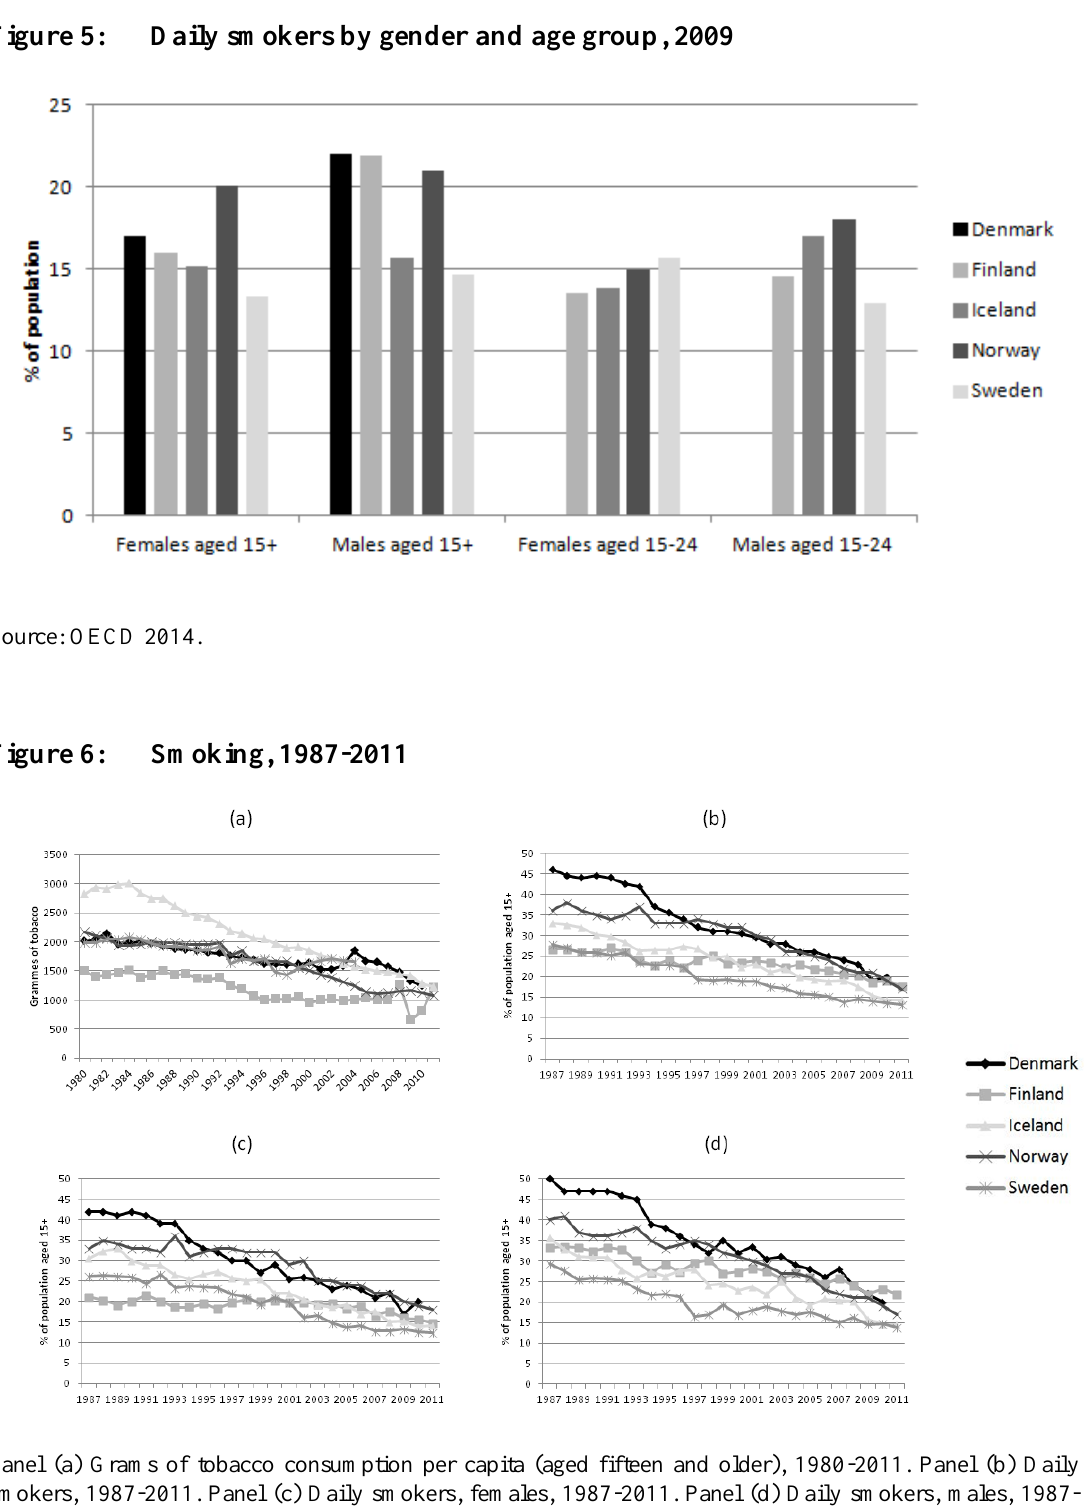
Panel (a) Grams of tobacco consumption per capita (aged fifteen and older), 1980-2011. Panel (b) Daily smokers, 1987-2011. Panel (c) Daily smokers, females, 1987-2011. Panel (d) Daily smokers, males, 1987- 2011. Source: OECD